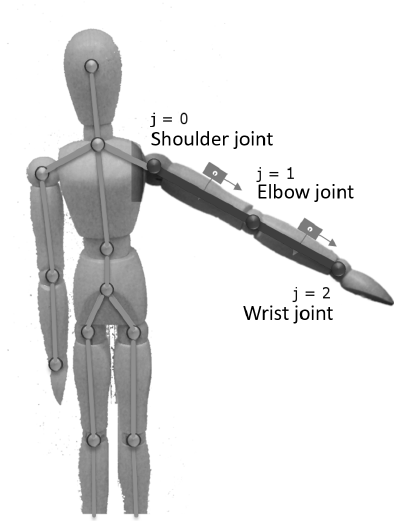
Figure 9. The hand joints simplified hierarchical model.